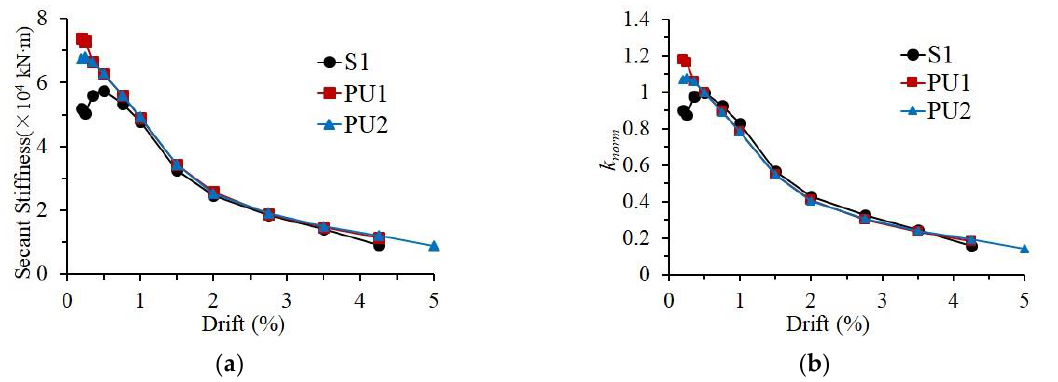
Figure 10. Stiffness degradation of the specimens. ( a ) Actual curve, ( b ) normalized curve.